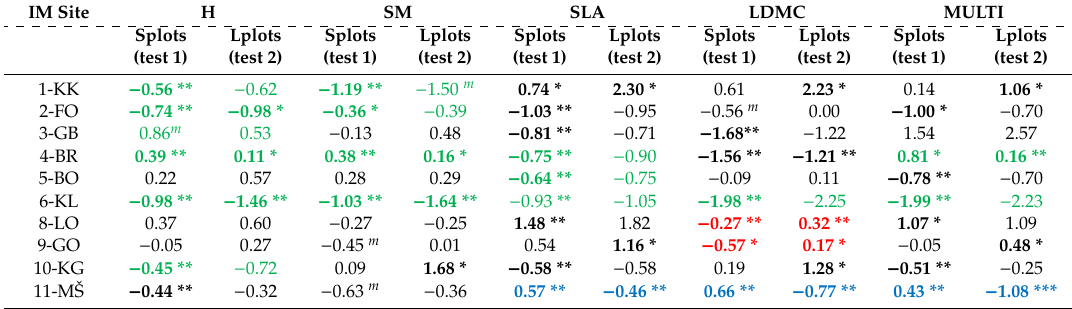
− 0.05 − 0.57 * 0.48 * 10-KG − 0.45 ** − 0.72 0.09 1.68 * − 0.58 ** − 0.58 0.19 − 0.25 11-MŠ − 0.44 ** − 0.32 − 0.63 m − 0.36 0.57 ** − 0.46 ** 0.66 ** − 0.77 ** 0.43 ** − 1.08 *** Significant results are indicated in bold (* p < 0.05, ** p < 0.01, *** p < 0.001, m—marginally significant ( p < 0.1)). The green color denotes the comparisons of SES values where the SES for Lplots was lower than the SES for Splots, supporting our hypothesis that FDis in Lplots would exhibit more convergent diversity patterns (i.e., lower SES values) compared to Splots. Values in blue denote the situations where this ratio was highly significant (i.e., significantly positive SES in Splots and significantly negative SES in Lplots). The red color denotes the opposite situation, indicating where our expectations about scale-dependent forest community assembly processes were not